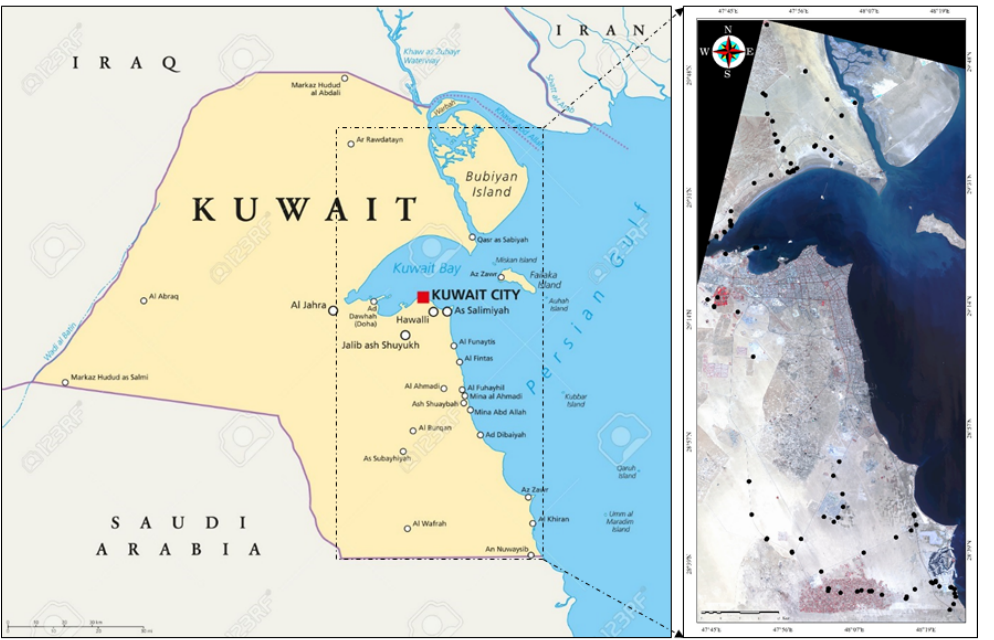
Figure 2. Study site and sampling point locations.